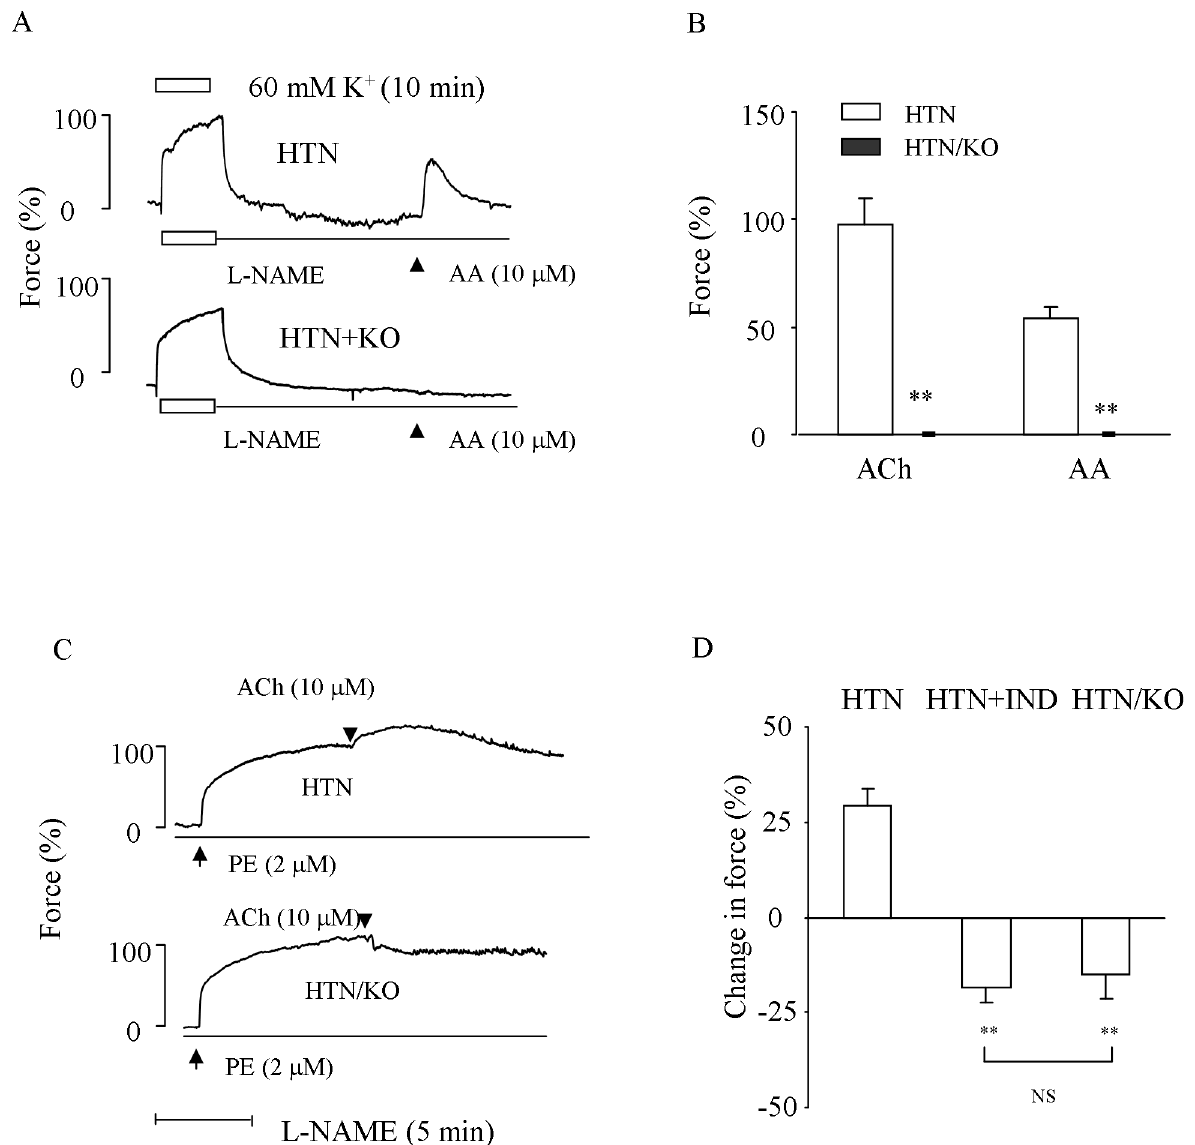
Fig 6. Effect of COX-1 -/- on the response to COX substrate AA and/or that evoked by ACh in NOS-inhibited HTN carotid arteries. A : representative traces showing that contraction evoked by AA in HTN (top) or that in COX-1 -/- 2K1C hypertensive vessels (HTN/KO; bottom) arteries. B : summary of the response evoked by ACh (10 μ M) and that to AA (10 μ M) in HTN/KO as compared to HTN counterparts. C : representative traces showing responses evoked by ACh (10 μ M) in HTN (top) and HTN/KO arteries (bottom) pre-contracted with PE (2 μ M). D : Summarized results of C together with that obtained with